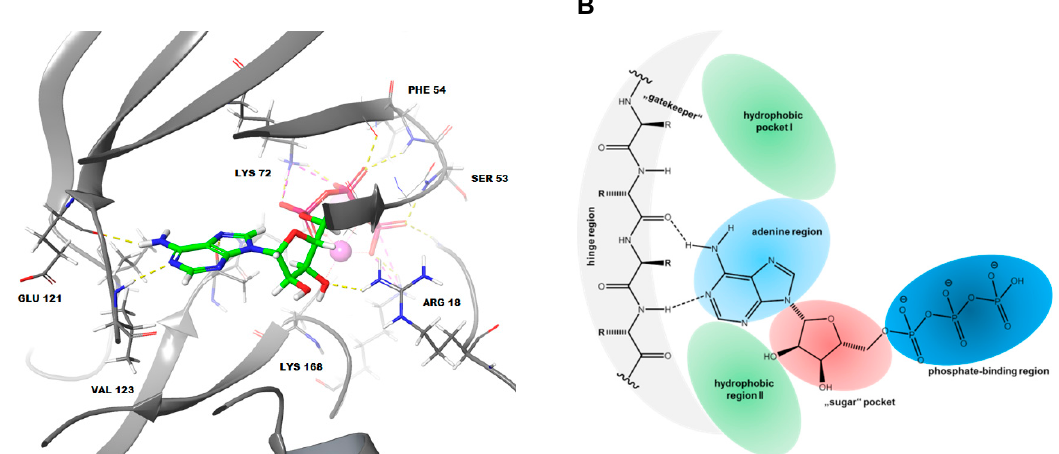
Figure 1. ( A ) Binding mode of adenosine triphosphate (ATP) within the binding pocket of cyclic adenosine monophosphate (cAMP) dependent protein kinase (pdb 4WB5 [7]). Hydrogen-bond interactions are shown as dashed lines. ( B ) Schematic representation of binding areas within the ATP binding site showing adapted interaction areas as suggested by the Traxler model.